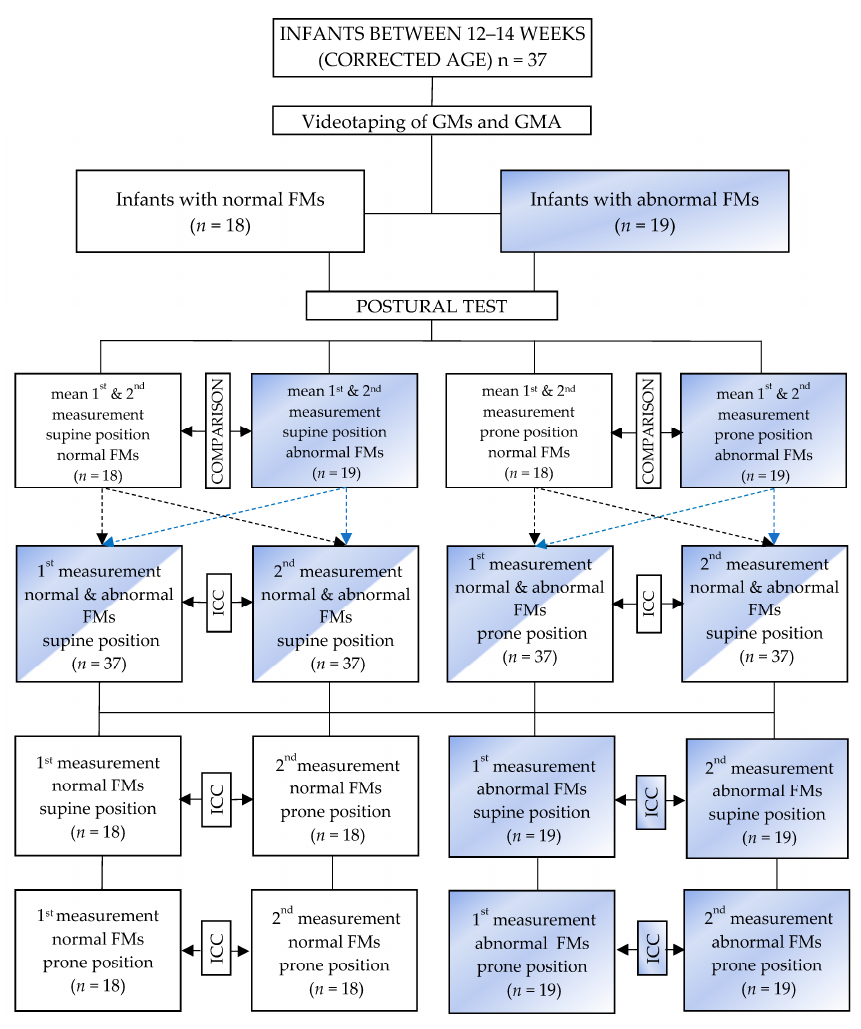
Figure 1. Study design.